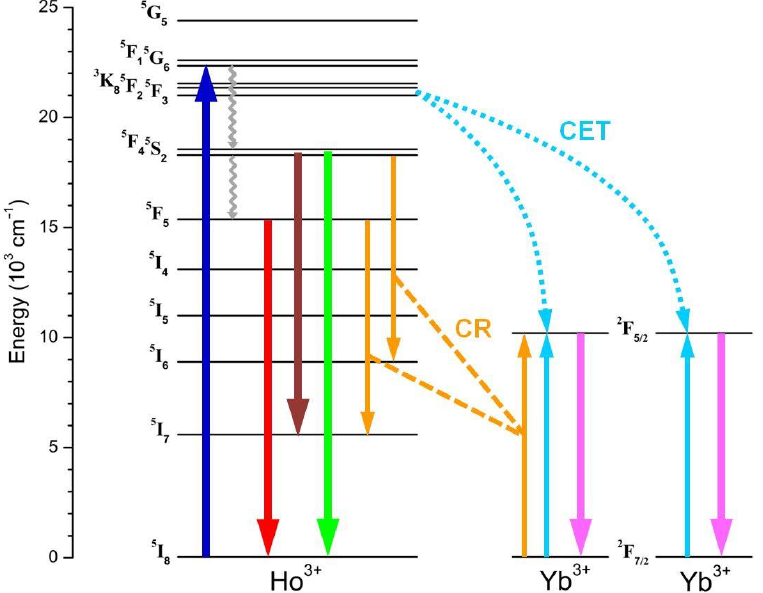
Figure 8. Scheme of the energy level diagram representing the photophysical mechanisms involved in the downconverted PL emissions observed for the Ln 3+ -doped NaBiF 4 samples. The blue upward arrow refers to Ho 3+ excitation into high-energy 4f levels; thick downward arrows refer to Ho 3+ radiative relaxations in the visible range, and Yb 3+ excited-state relaxation (purple arrow); cyan and orange arrows refer to Ho 3+ -Yb 3+ cooperative energy transfer (CET) and cross-relaxation (CR) processes, respectively; grey wavelike arrows refer to multiphonon relaxations.